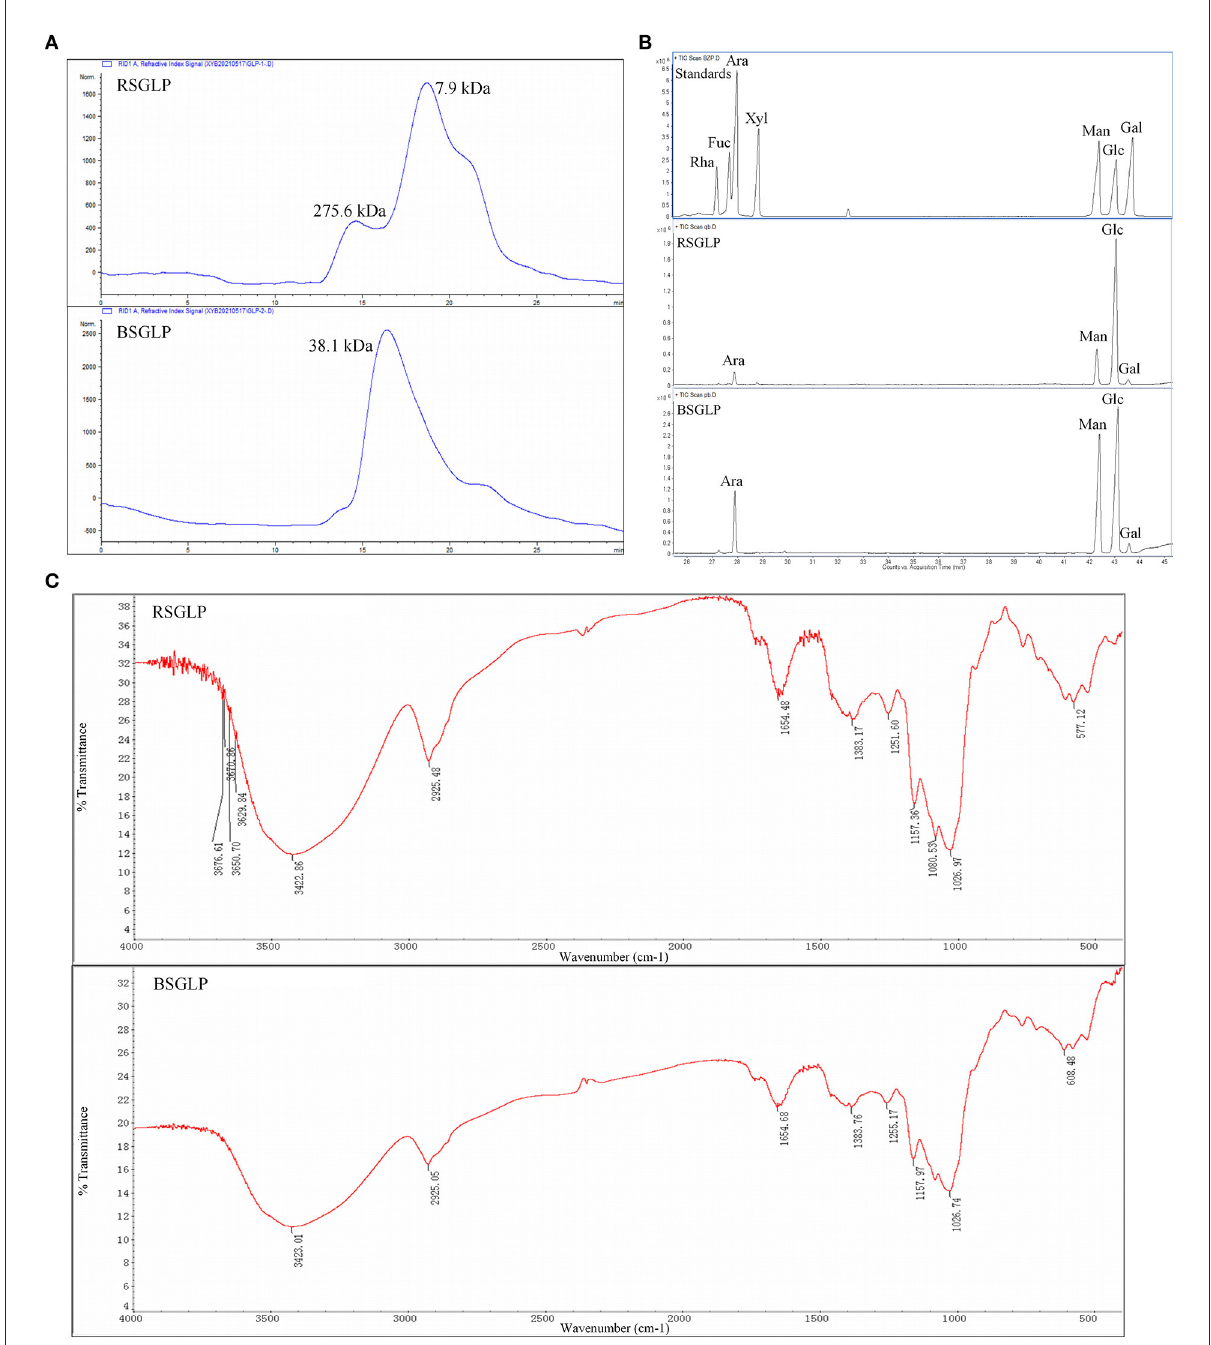
FIGURE1 Chemical characterization of RSGLP and BSGLP. (A) The HPGPC chromatogram of standards, RSGLP, and BSGLP to determine molecular weight. (B) The GC-MS analysis of the monosaccharides composition in RSGLP and BSGLP. The standards Rha, Fuc, Ara, Xyl, Man, Glu, and Gal were located in the order of retention time as shown in the GC–MS chart. (C) FT-IR spectrum of RSGLP and BSGLP.